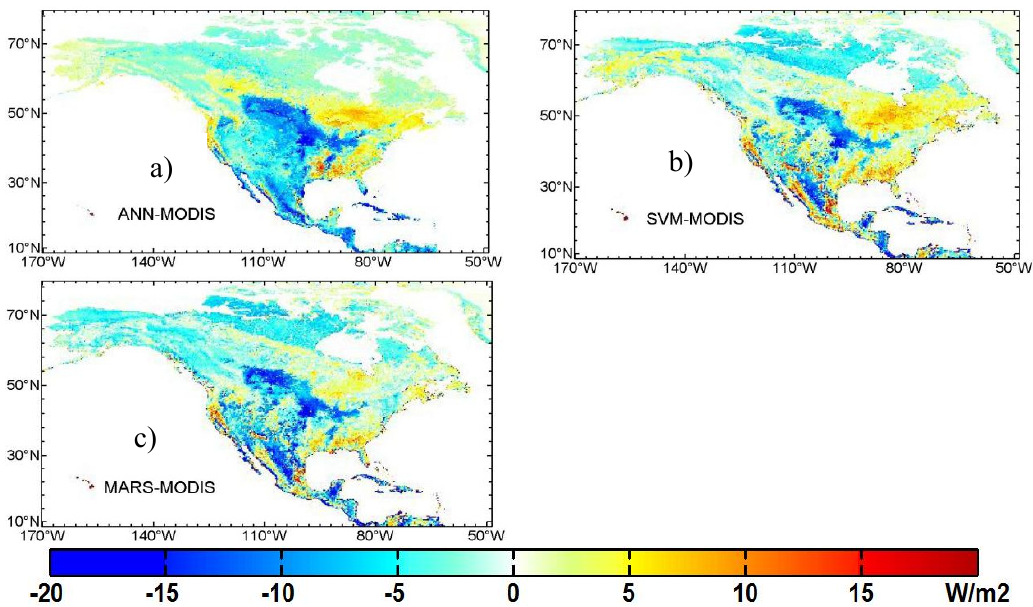
Figure 12. Spatial differences in the average annual terrestrial LE (2002–2004) between MODIS LE product and LE product using three machine learning algorithms.